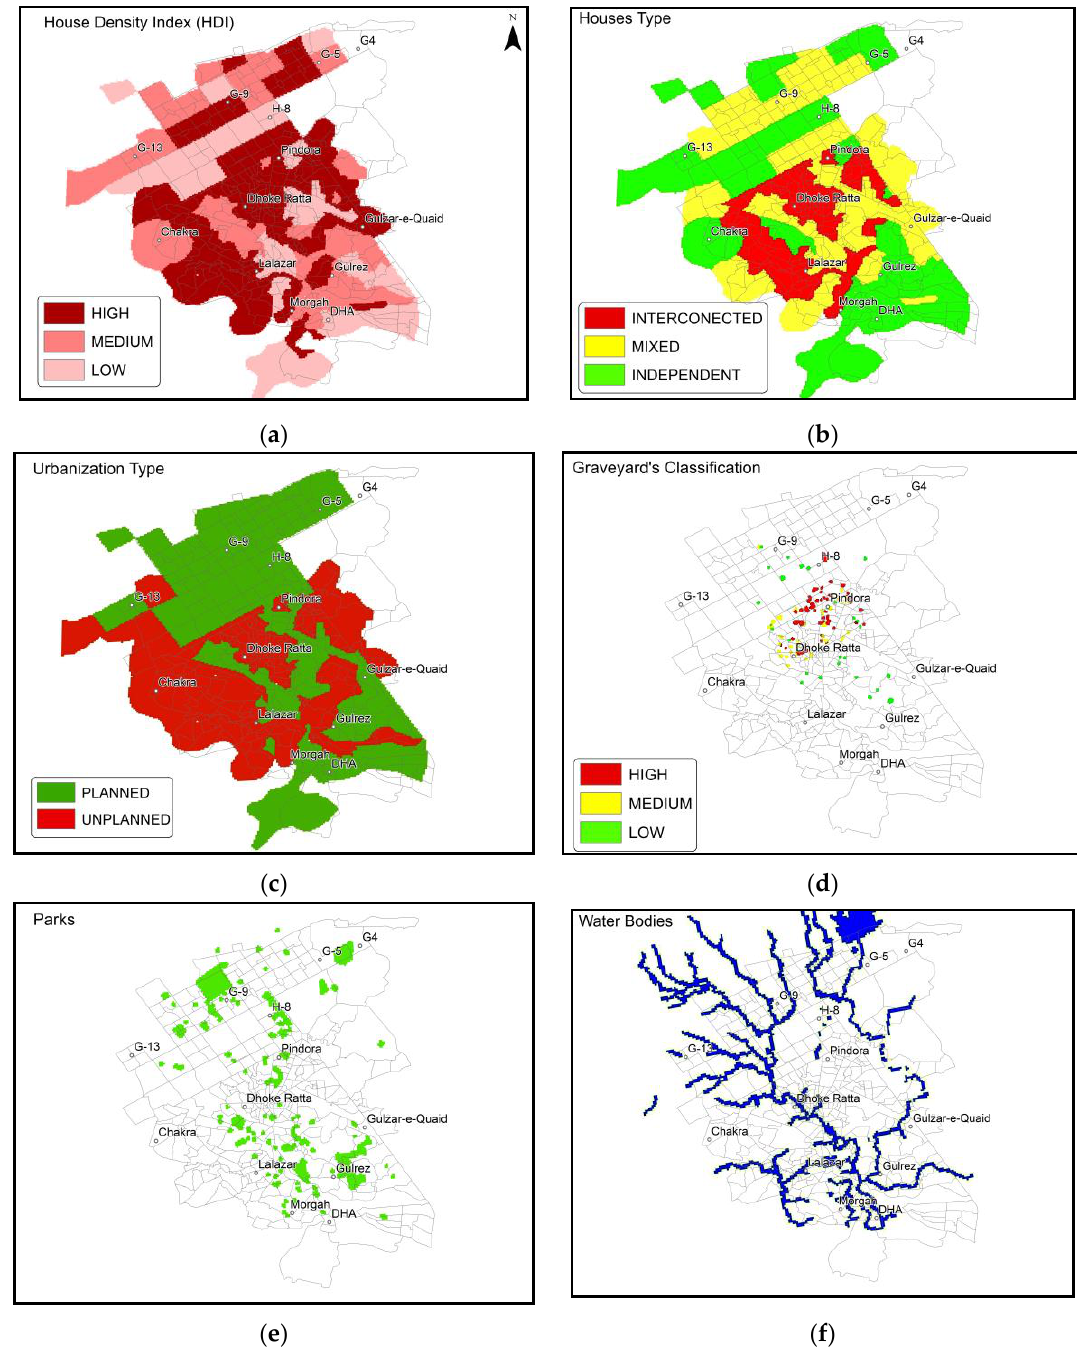
Figure 10. The raster input layers to produce Threat Index map. Each layer has been assigned a weight value and layers have been overlaid by two methods: weighted sum; weight overlay [46]. ( a ) HDI; ( b ) House type; ( c ) Urbanization type; ( d ) Graveyards; ( e ) Parks; ( f ) Water bodies.